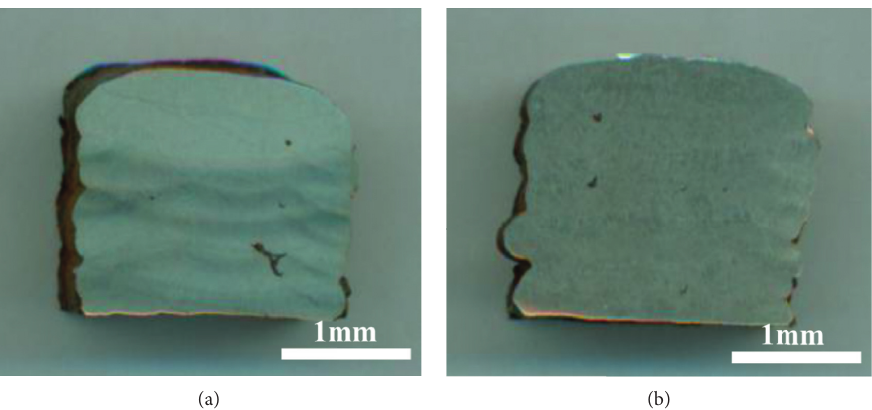
Figure 2: Cross-sectional morphology of the 2.25Cr1Mo0.25V heat-resistant steel produced by WAAM: (a) the as-cladded state for sample #1 and (b) the postcladding heat-treated (705 ° C × 1 h) state for sample